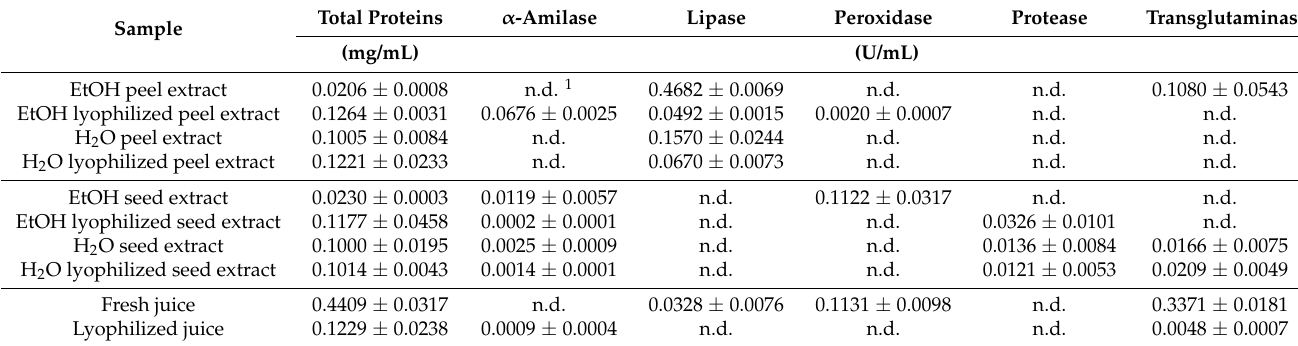
Table 1. Activity of enzymes found in P. granatum